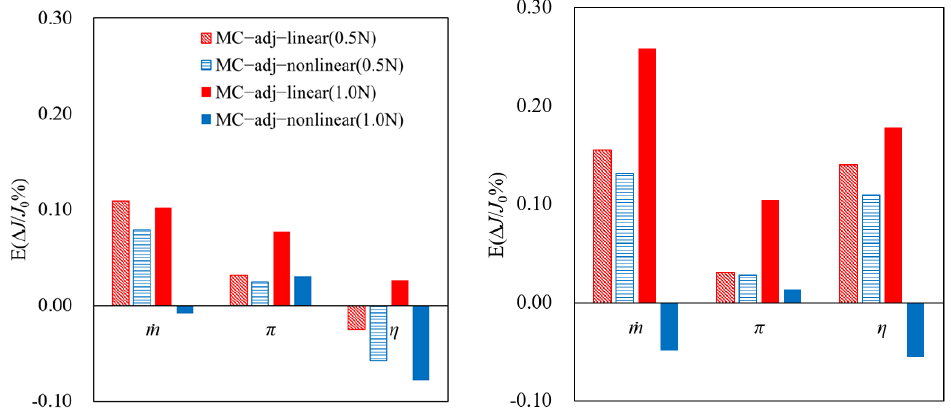
Figure 13. The mean of normalized performance deviations at the design ( left ) and near-stall conditions ( right ) of 100% speeds and that of low pressure ratio ( left ) and high pressure ratio ( right ) operating points at 50% speed by the MC − adj − linear and MC − adj − nonlinear